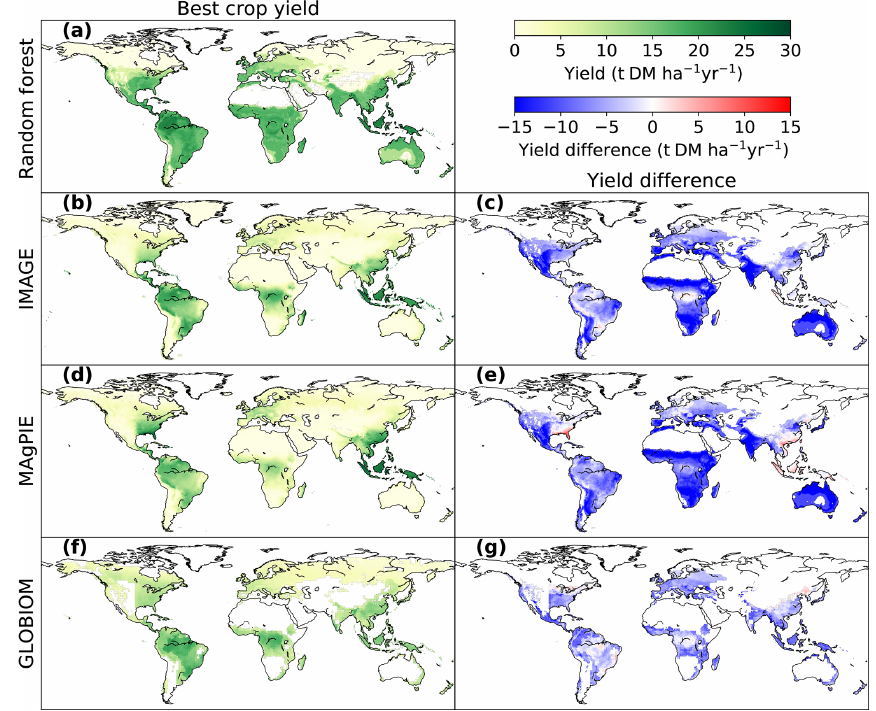
Figure 4. Comparison of bioenergy crop yields between the RF map and maps used in three IAMs (IMAGE, MAgPIE and GLOBIOM). Panels (a, b, d, f) are the best crop yields from each dataset, and the panels (c, e, g) refer to the yield differences between RF and each IAM map (IAM yields minus RF yields where yields are available in both paired maps). The best-crop-yield map from RF (a) is the same as Fig. 3f. The best crop yields in IMAGE and MAgPIE (b, d) are the higher yields between woody and herbaceous bioenergy crops in each grid cell. The best crop yields in GLOBIOM (f) are the yields of woody crops (short-rotation trees), since there is no herbaceous bioenergy crop in